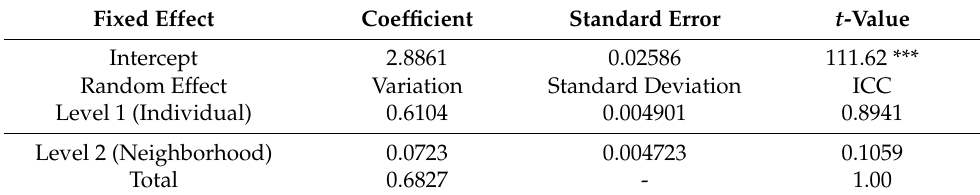
Table 3. Result of unconditional model analysis.